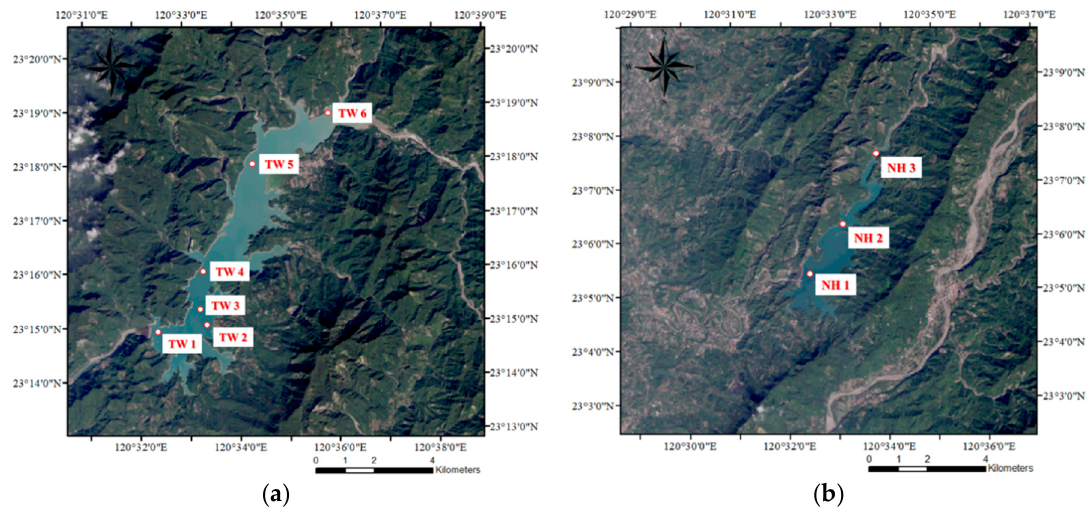
Figure 1. Turbidity monitoring station location of ( a ) Tseng-Wen and ( b ) Nan-Hwa reservoir. (Study area satellite images were taken in 2017/11/28 by Landsat 8).